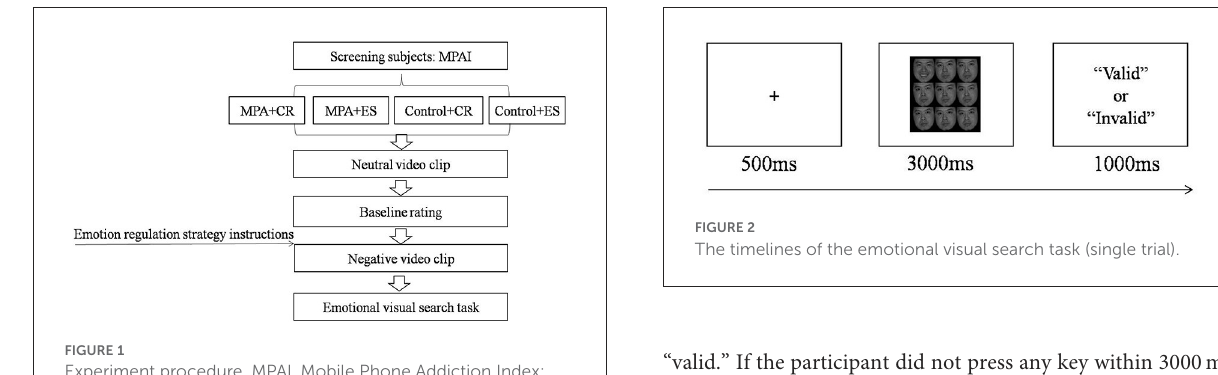
FIGURE1 Experiment procedure. MPAI, Mobile Phone Addiction Index; MPA, Mobile phone addiction; CR, Cognitive reappraisal; ES, Expressive suppression.